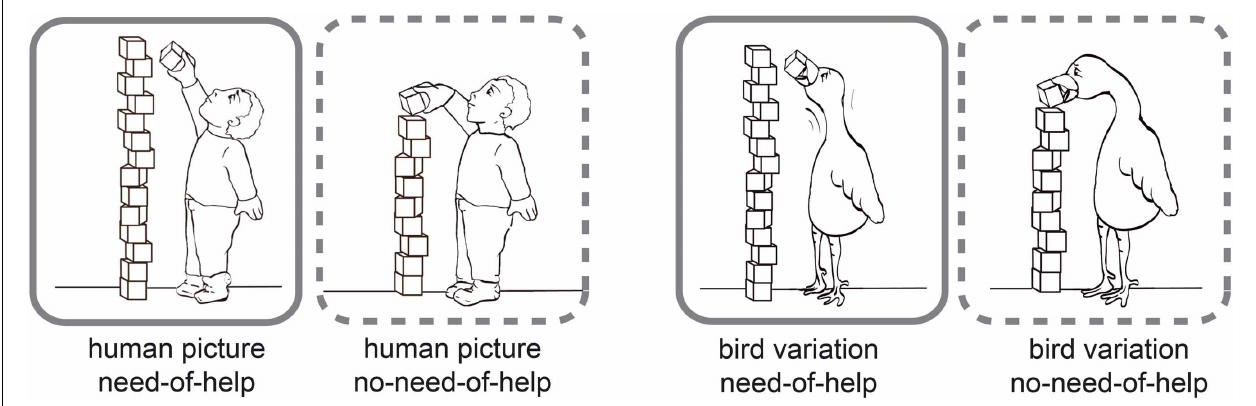
FIGURE 1 | Example stimuli. Need-of-help (NoH) variations are framed by solid lines, no-need-of help (no-NoH) variations by dashed lines. A picture pair of a child (boy, kindergarten age) is shown on the left side, the corresponding bird picture pair on the right side.